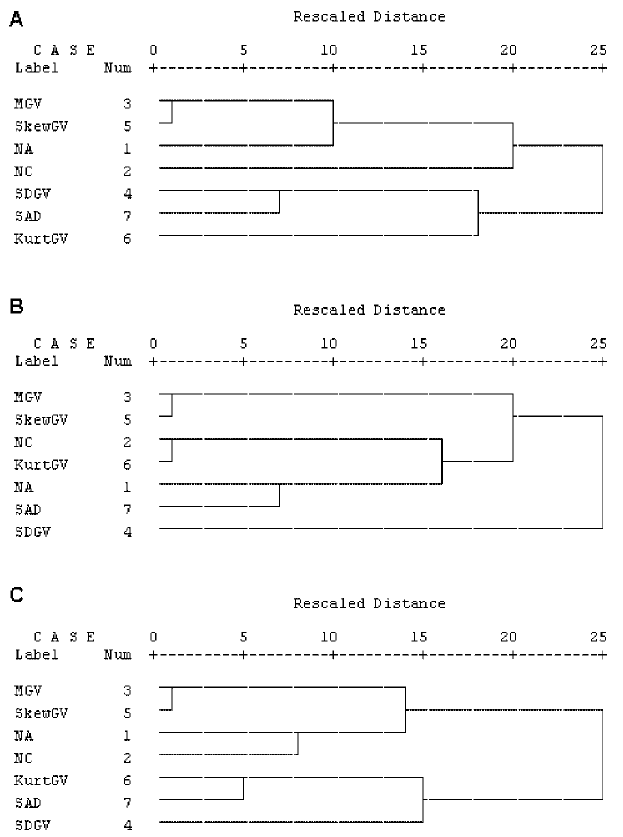
Fig. 1. Horizontal dendrogram representing steps in hierarchical clustering (centroid method) of karyometric variables: A – using level-1 CC obtained in MMM; B – using level-2 CC obtained in MMM (or, equally, using summary statistics method); C – using “pooling”